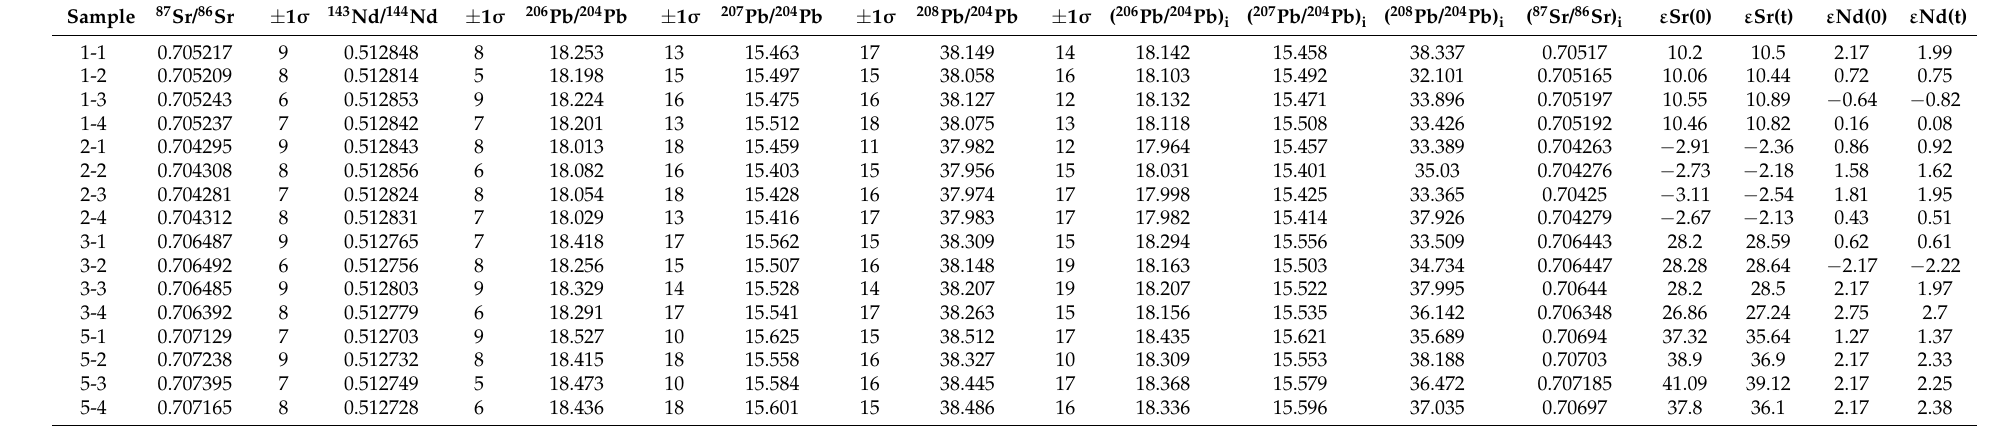
Table 3. Sr-Nd-Pb isotopic compositions of the Jiangling basaltic